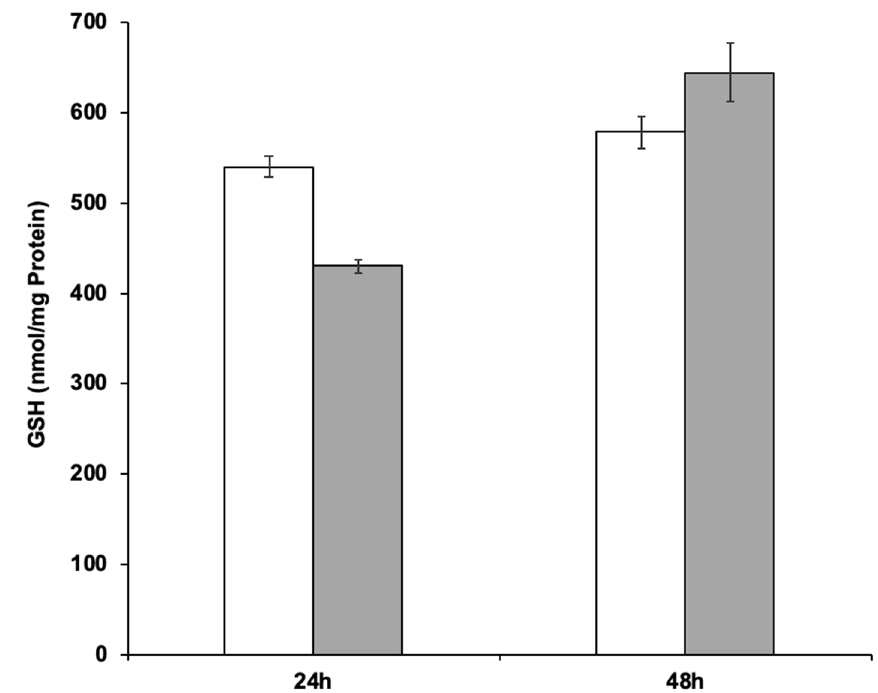
Figure 4. GSH production of Y. lipolytica strains RIY231 (p TEF - ylGSH 1- ylGSH 2) , RIY383 (p TEF- ylGSH1-ylGSH2-GUT1-GUT2 ) and RIY389 (p TEF-ylGSH1-ylGSH2-INU1 ) grown for 24 h in